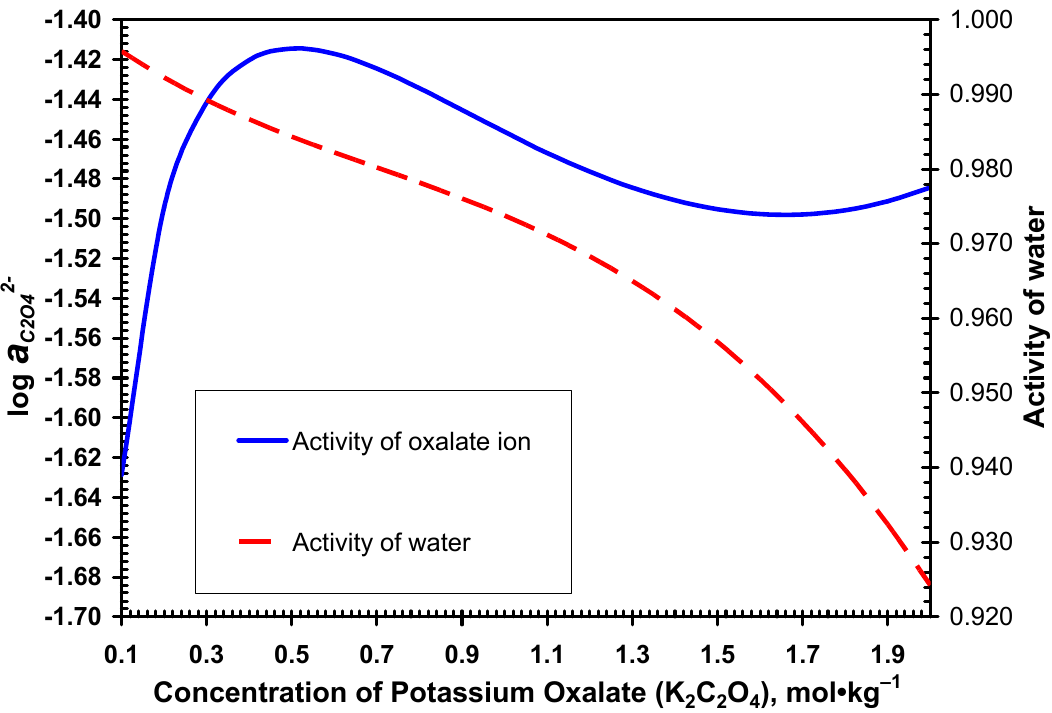
-1.70-1.68-1.66-1.64-1.62-1.60-1.58-1.56-1.54-1.52-1.50-1.48-1.46-1.44-1.42-1.40 Figure 7. Predicted activities of oxalate species and water for potassium oxalate (K 2 C 2 O 4 ) solutions relevant to desulphurization of lead sulfate in oxalate-bearing solutions at 25 °C and pH m = 6.5 (negative logarithm of hydrogen ion concentration on molal scale). Activities of oxalate species and water activities of potassium oxalate solutions are calculated according to the thermodynamic parameters from [13]), which are listed in Tables 1 and